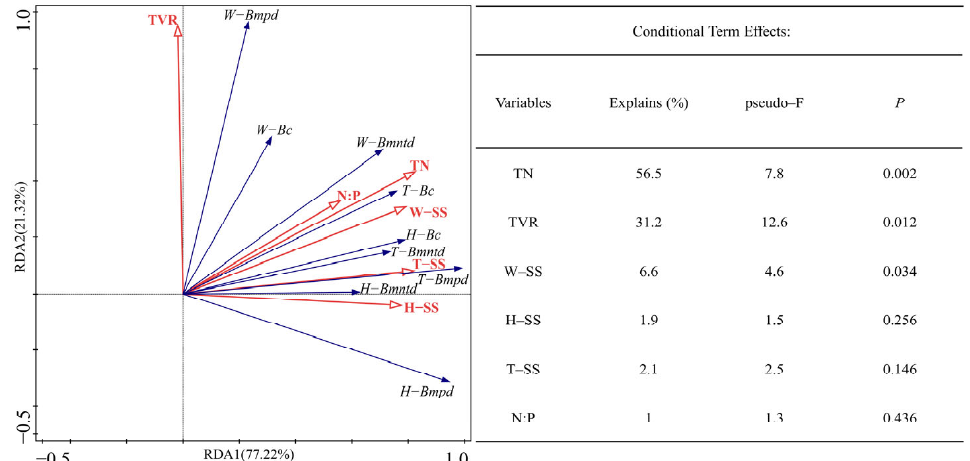
Figure 6. The redundancy analysis on the relationship between plant community β -diversity and soil C:N:P stoichiometry, TVR, and SS. TVR indicates the time after vegetation restoration (in years). SS indicates endemic plants at each stage. “Total or T” represents the overall plant level of the investigated plant communities. “Herb or H” represents the herb plant level in the investigated plant communities. “Woody or W” represents the woody plant level in the investigated plant